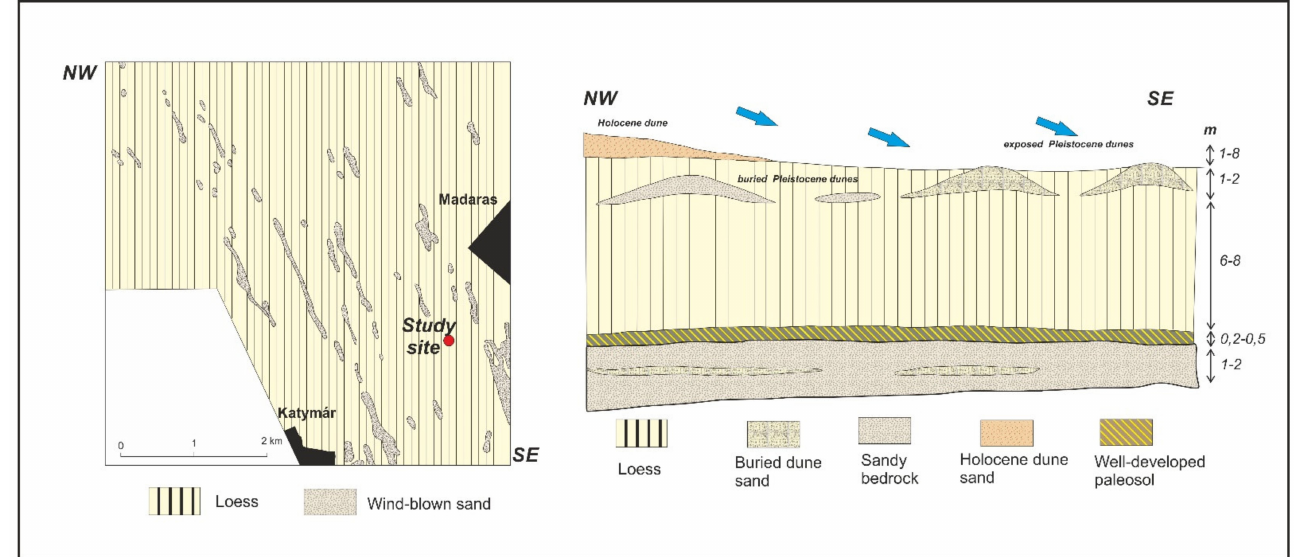
Figure 10. Surface geology and idealized sketch of the Late Pleistocene geohistory of the Hungarian part of the B á cska loess area (adopted from Moln á r and Krolopp